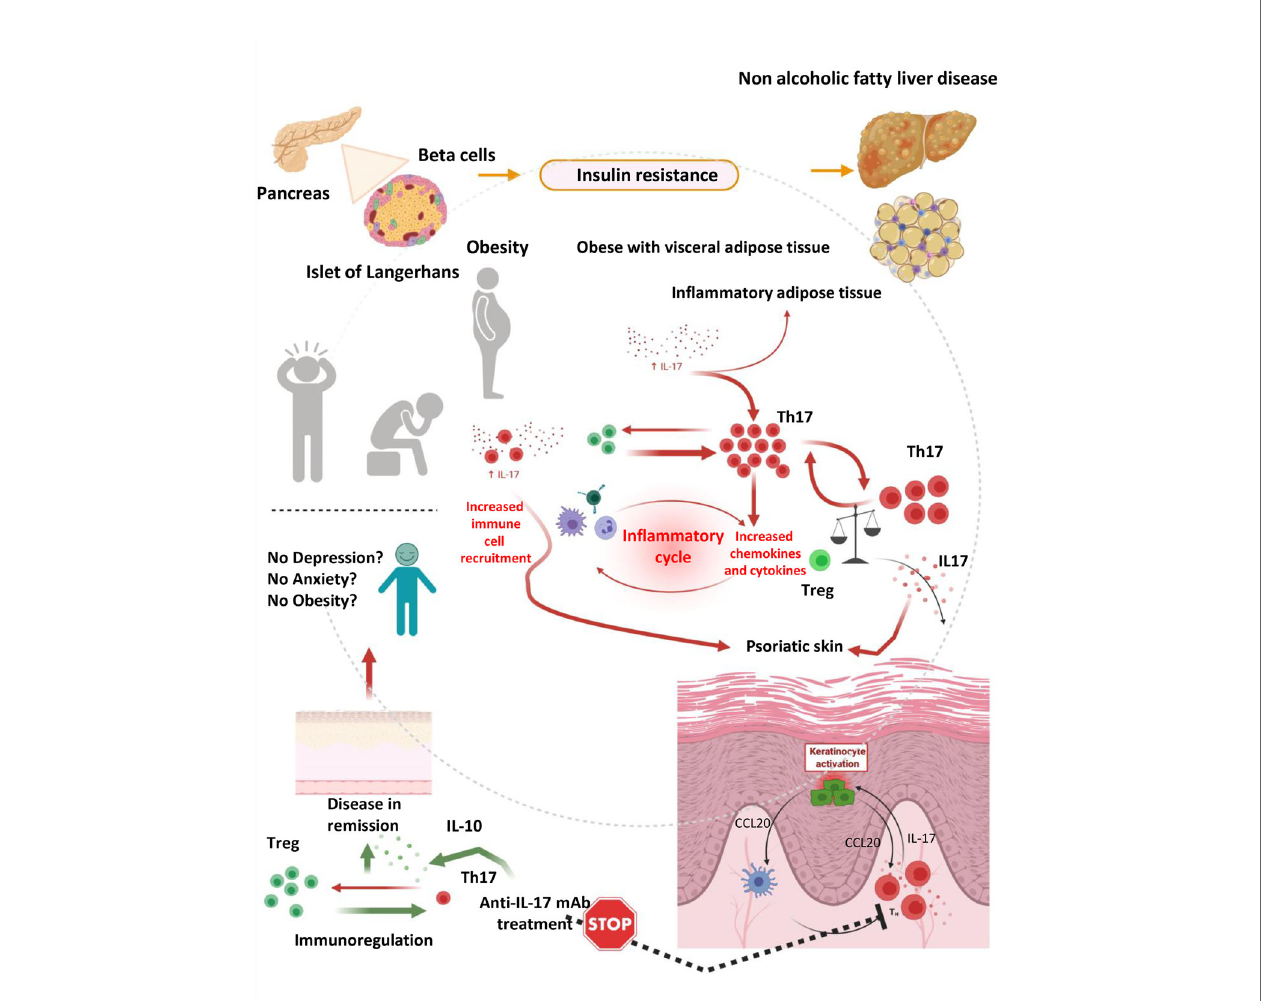
FIGURE 2 | The hypothesis of immunedysregulation in obese depressed patients with psoriatic disease. An in fl ammatory response mediated by IL-17 producing cells such as Th17 is playing a pivotal role in the development of obesity, depression and psoriasis, in isolation or in combination. Immundysregulation manifested as increased expression of IL-17 and IL-17 producing cell subsets and diminished expression of regulatory cells (Tregs) and related cytokines (such as IL-10) is driving complex reactions leading to the development and progression of psoriatic disease and concomitant anxiety, depression and obesity. Those manifestations can partially be attributed to the in fl ammatory milieu, which fosters consistent in fl ammation, keratinocyte activation, cellular damage and skin destruction, as well as interconnected depressive disorders and weight gain. This vicious circle is stopped by IL-17 selective inhibitors, which can lead to the remission of skin lesions (and in the remission of arthritogenic features in the case of psoriatic arthritis or axial spondylarthritis) (prepared with